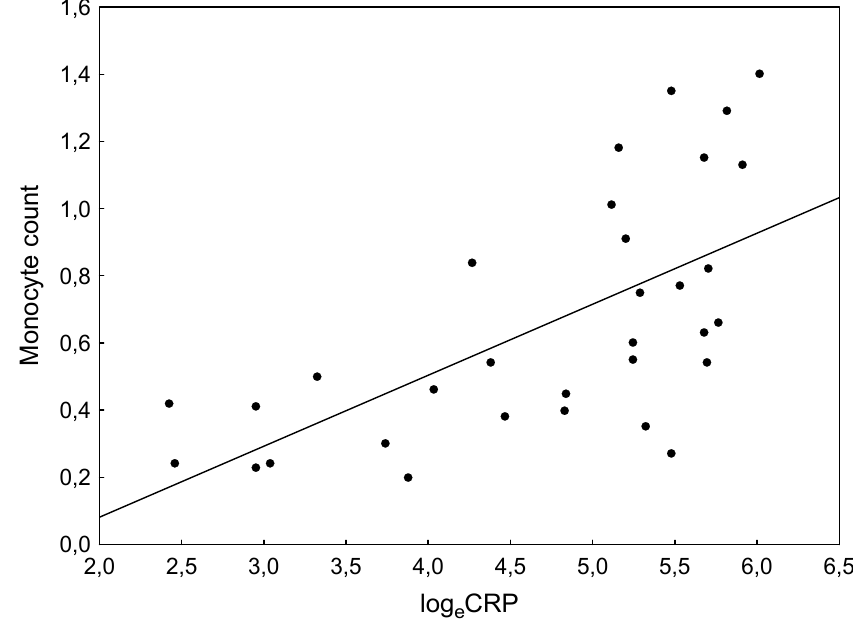
Fig. 4 Regression line for the relationship between monocyte count and CRP plasma concentration (log e -transformed) in AP patients on the 2 nd day after admission. The regression equation: Monocytes ( × 10 3 / μ l) = -0.34 + 0.21 × log e CRP